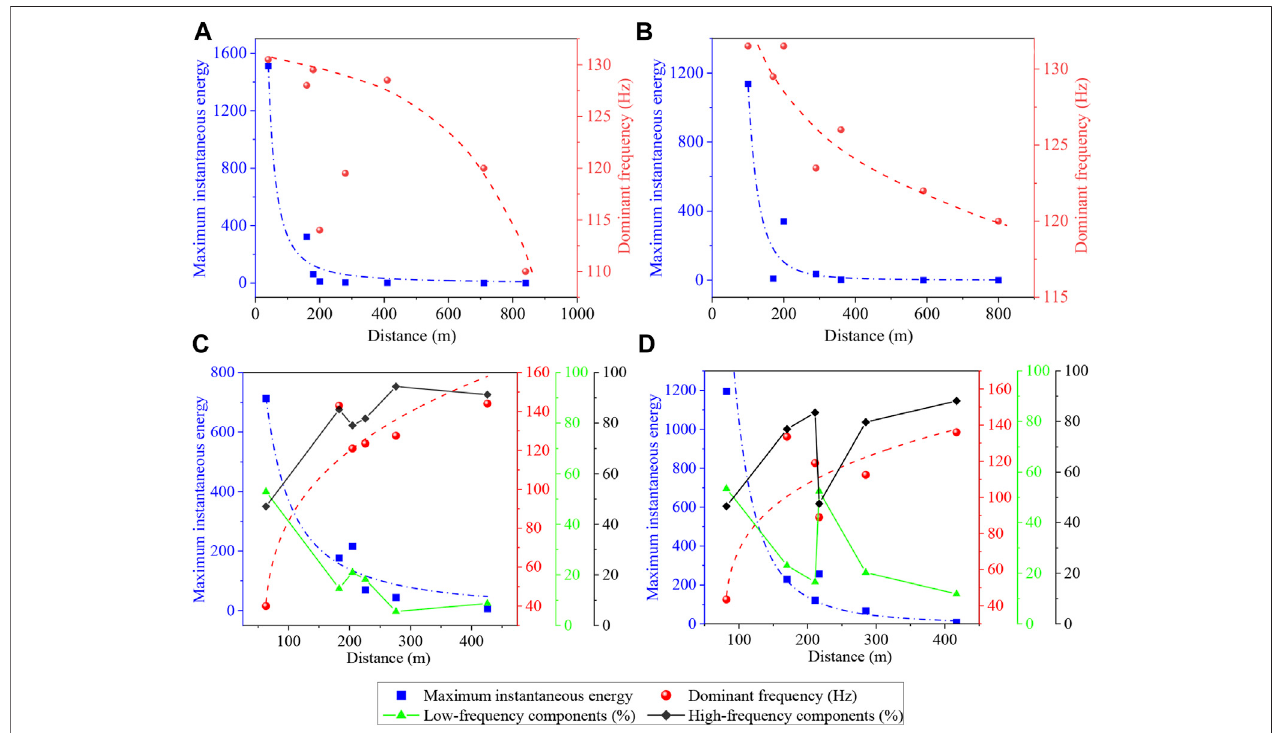
FIGURE 7 | Maximum instantaneous energy, frequency, and propagation distance. (A) M-M-1; (B) M-M-2; (C) DB-M-2; and (D) DB-M-4.